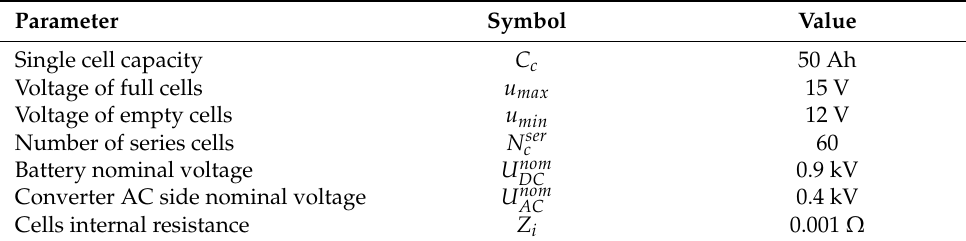
Table 8. BESS common parameters 1 .